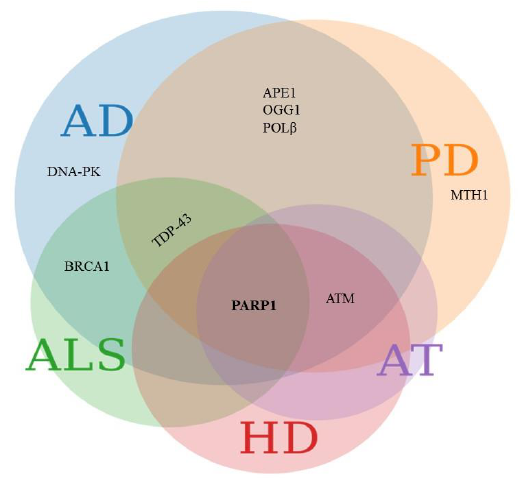
Figure 2. Common DNA damage response (DDR) proteins involved in various NDDs. The Venn diagram represents DDR proteins linked with various NDDs. Proteins involved in Alzheimer’s disease (AD) are depicted in the blue circle, Parkinson’s disease (PD) in orange, amyotrophic lateral sclerosis (ALS) in green, Huntington disease (HD) in pink and ataxia telangiectasia (AT) in purple. APE1, OGG1 and POL β are involved in both AD and PD. Pathology related to the ALS associated protein TDP-43 is seen in both AD and PD. BRCA1 is involved in ALS and AD. Ataxia